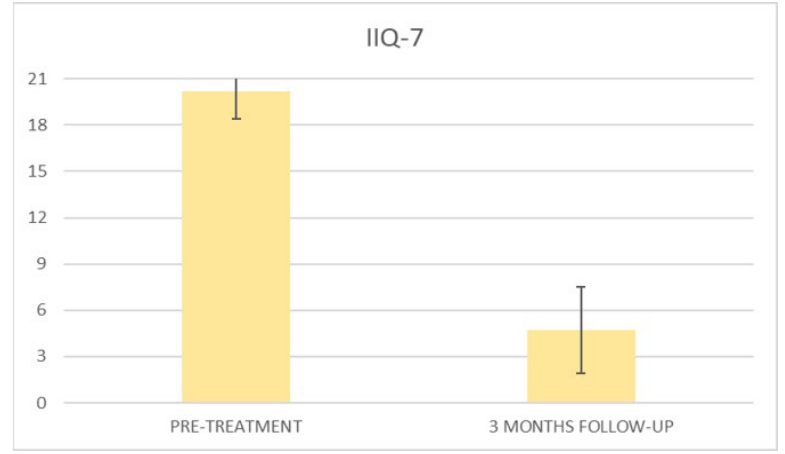
Figure 7. Histogram representation of the results from IIQ-7 at baseline and at 3 months follow-up. According to the answers, at the baseline, the patients’ health condition and relation- ships were affected, and social and emotional limitations were present. No side effects were